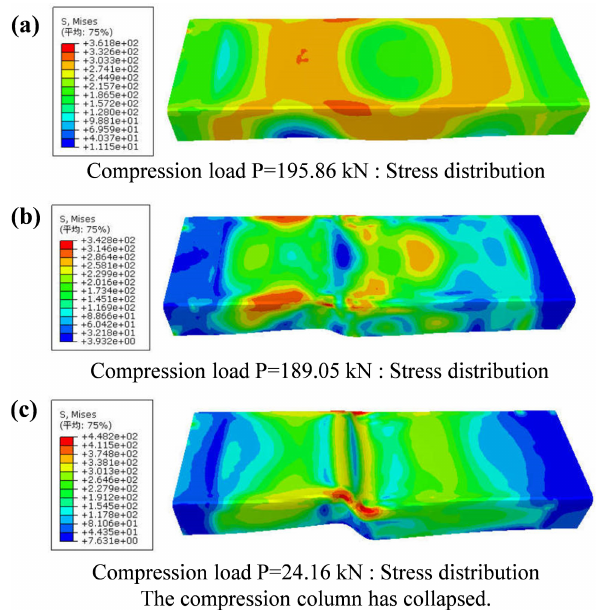
Figure 12: Stress and deformation process of the outer aluminum alloy sheet of DCYG-A